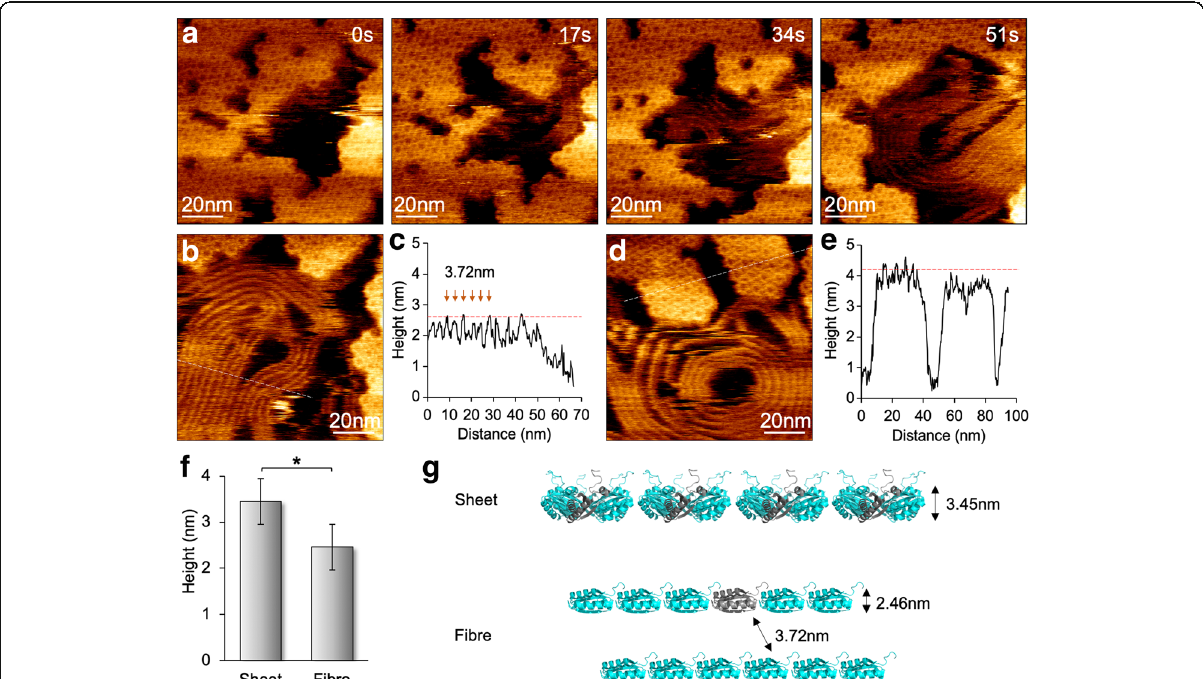
Fig. 4 Formation and dynamics of fibrous structures along with the shell sheet assemblies under HS-AFM. a Appearance of fiber-like structures during the disassembly of shell sheets composed of Hoch_5815 hexamers, as shown by AFM image series. b AFM topograph of fiber structures. c Cross-section analysis (dash line in panel b ) reveals a spacing of 3.72 ± 0.31 nm ( n = 30) between adjacent fiber structures, and the average height is 2.46 ± 0.22 nm ( n = 30). d AFM topograph of shell patches composed of Hoch_5815 hexamers. e Cross-section analysis (dash line in panel d ) reveals that the average height of Hoch_5815 hexamers is 3.45 ± 0.16 nm ( n = 25). f The fiber-like structures present a reduced height compared with flat sheets consisting of Hoch_5815 hexamers (* p < 0.05, two-way ANOVA). g Proposed organization and formation of the fiber-like